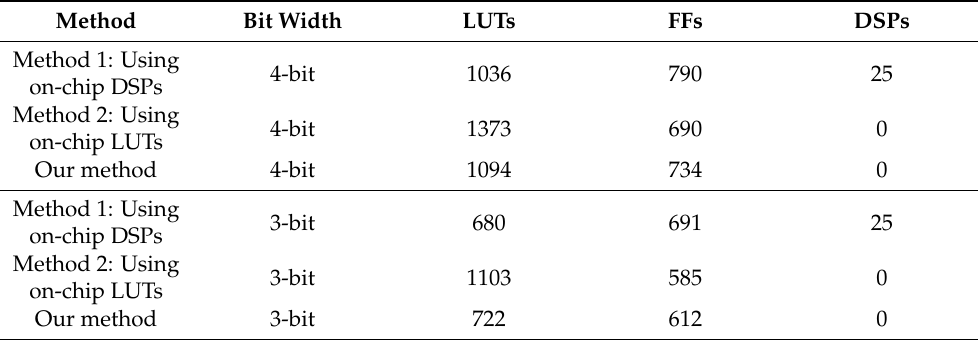
Table 11. On-chip resource occupation of a single convolution computation module based on different methods.